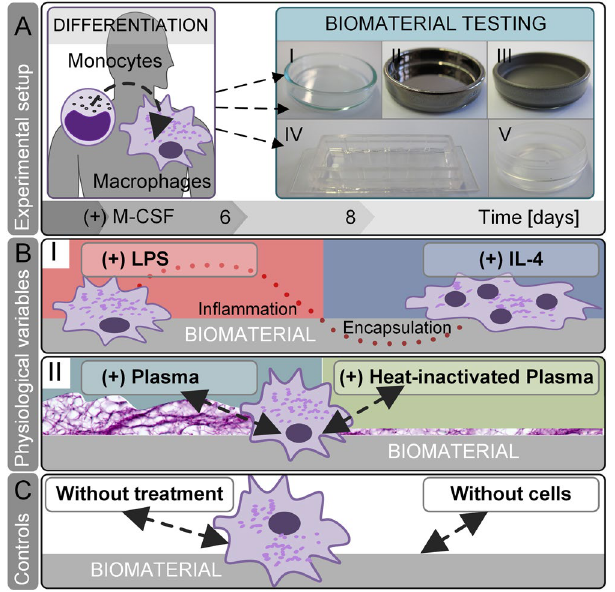
Figure 1. In vitro screening of physiological test conditions for the predictive power to evaluate a biomaterials’ fibrotic potential. ( A ) In our experimental setup, human blood-derived monocytes were differentiated by supplementation of macrophage colony-stimulating factor (M-CSF) to M2-like macrophages. Subsequently, macrophages were cultured on biomaterials for 48 h: (I) glass, (II) titanium, (III) PTFE, (IV) silicone and (V) PE. ( B ) On each material, we tested conditions that mimic the physiological in vivo niche on materials’ surface: (I) A common cause of implant failure - LPS contamination - polarizes macrophages’ fate towards pro-inflammation. In contrast, the presence of IL-4 in the immune niche strengthens a pro-survival cellular phenotype – the fusion of macrophages towards foreign body giant cells. (II) A biomimetic approach of protein- material interaction was resembled by applying human autologous blood-derived plasma on biomaterials surface. By calcification of plasma, a primary fibrous three-dimensional niche was formed. In comparison to native blood plasma, the inactivation of heat labile protein, e.g. complement, growth, and coagulation factors was assessed by heat-inactivation (HI) of human plasma. ( C ) As controls served test conditions without any additions and without